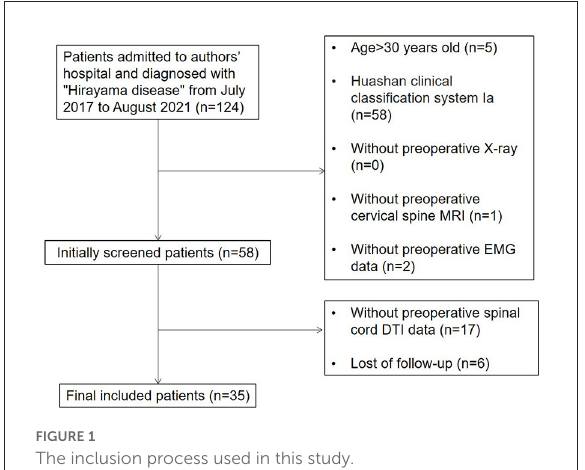
FIGURE1 The inclusion process used in this